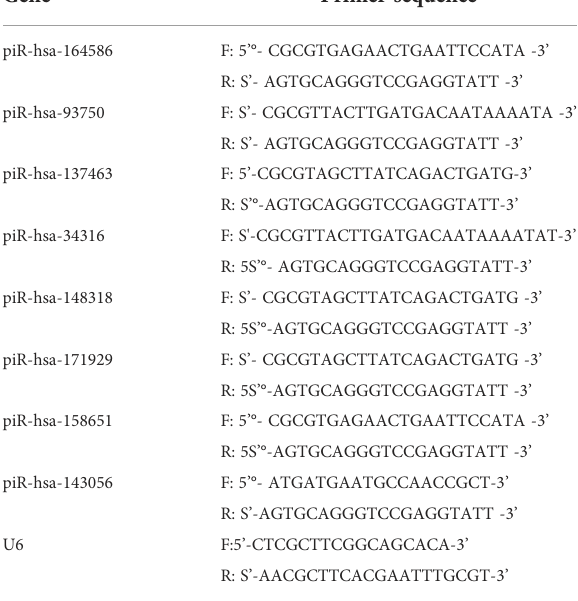
TABLE 1 qPCR primer